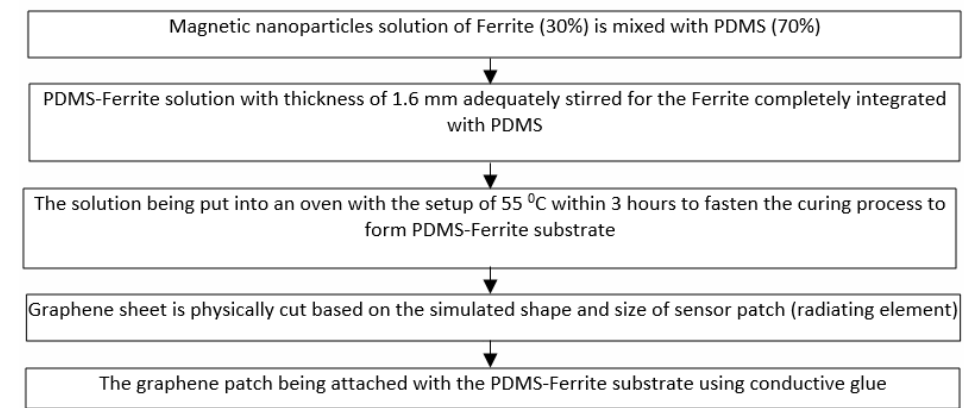
Figure 2. Processing steps for synthesizing the Magnetite PDMS Graphene Array Sensor.